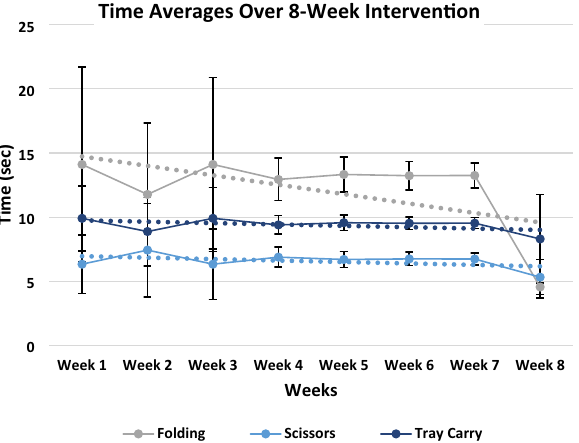
Figure 7. Time averages to complete each activity over the 8-week intervention period. Many time averages for each activity significantly overlapped. Folding, Scissors, and Tray Carry were good representatives of what was typically seen in all activities